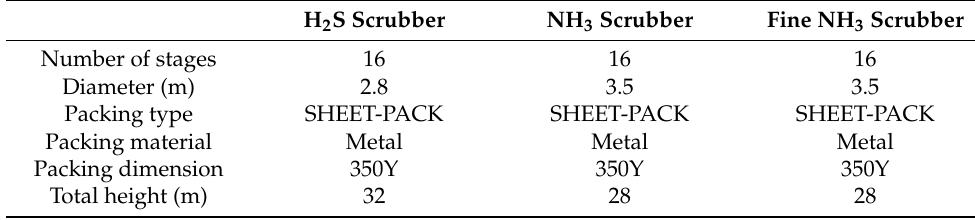
Table 1. Specification of the three